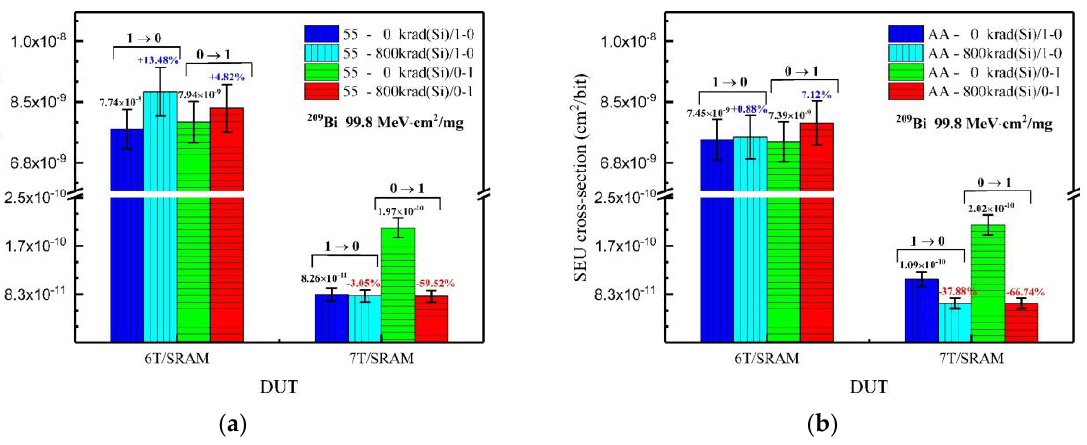
Figure 7. SEU cross-sections characterized by Bi ion versus layout structure for SOI SRAMs after deposition 800 krad(Si). The vertical column represents data for the “ 1 → 0 ” upset, the horizontal column represents data for the “ 0 → 1 ” upset. The data pattern applied during SEU testing is ( a ) 55h and ( b ) AAh.